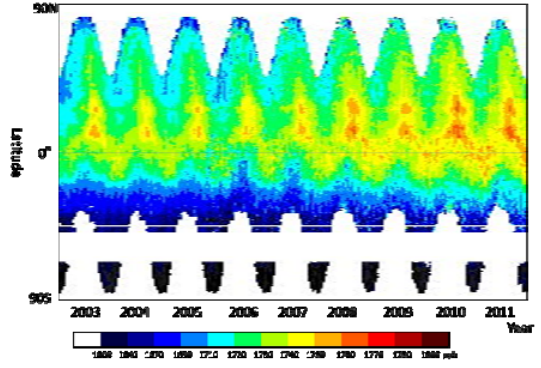
Figure 5. Interannual variation in mean CH 4 concentration by latitude zone over continental regions